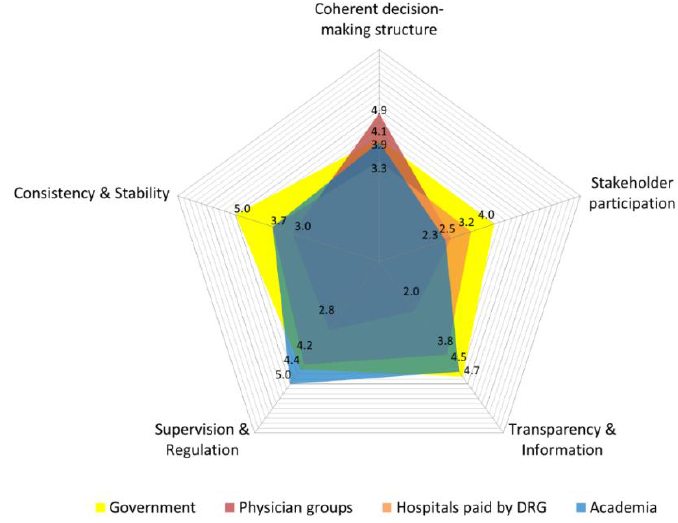
Figure 2. Governance performance: assessment by stakeholders .